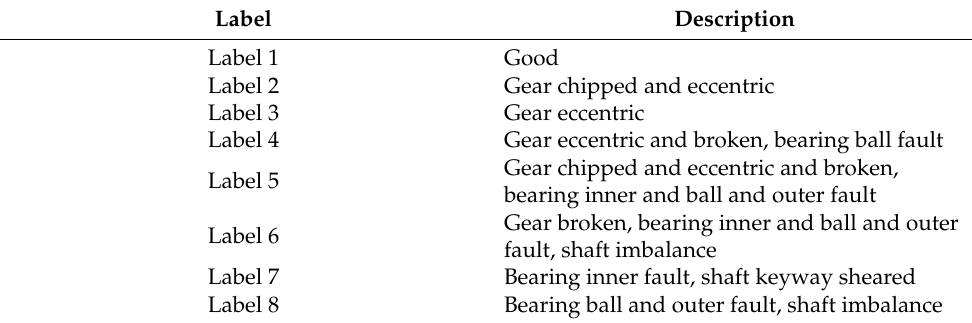
Figure 4. Gearbox used in PHM 2009 challenge data. Table 2. A brief description of the